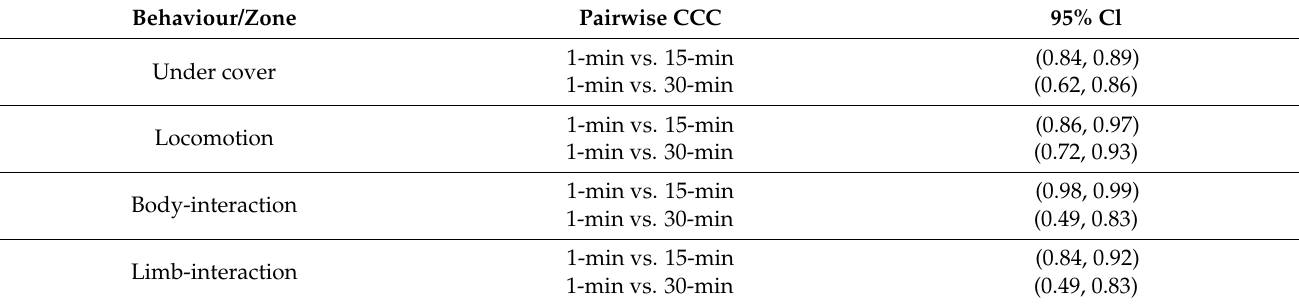
Table 3. The upper and lower 95% confidence interval (CI) results from Lin’s (1989) pairwise Concordance Correlation Coefficient (CCC). The enclosure usage, locomotion, body-interaction, and limb-interaction results using 1-min sampling intervals were tested against the results using 15-min and 30-min sampling interval lengths. 27 handling and no-handling days were used in the test.